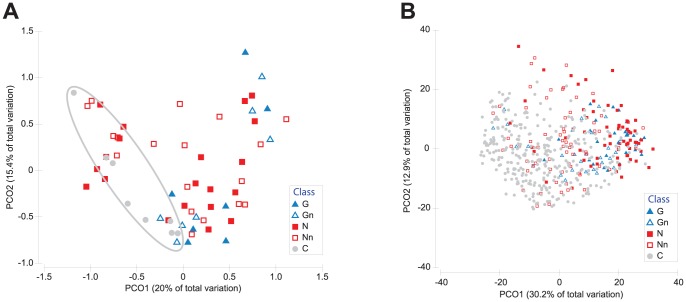
Principal Coordinate Analysis (PCO) plots for the bacterial communities assessed by high-density microarrays specific using probes specific of the genus level (A) and by low-density microarrays (B) using all designed probes.The analysis was based on the Bray-Curtis similarity matrix constructed using normalized signal intensities for the corresponding probes. Gray line delimitates control group samples.